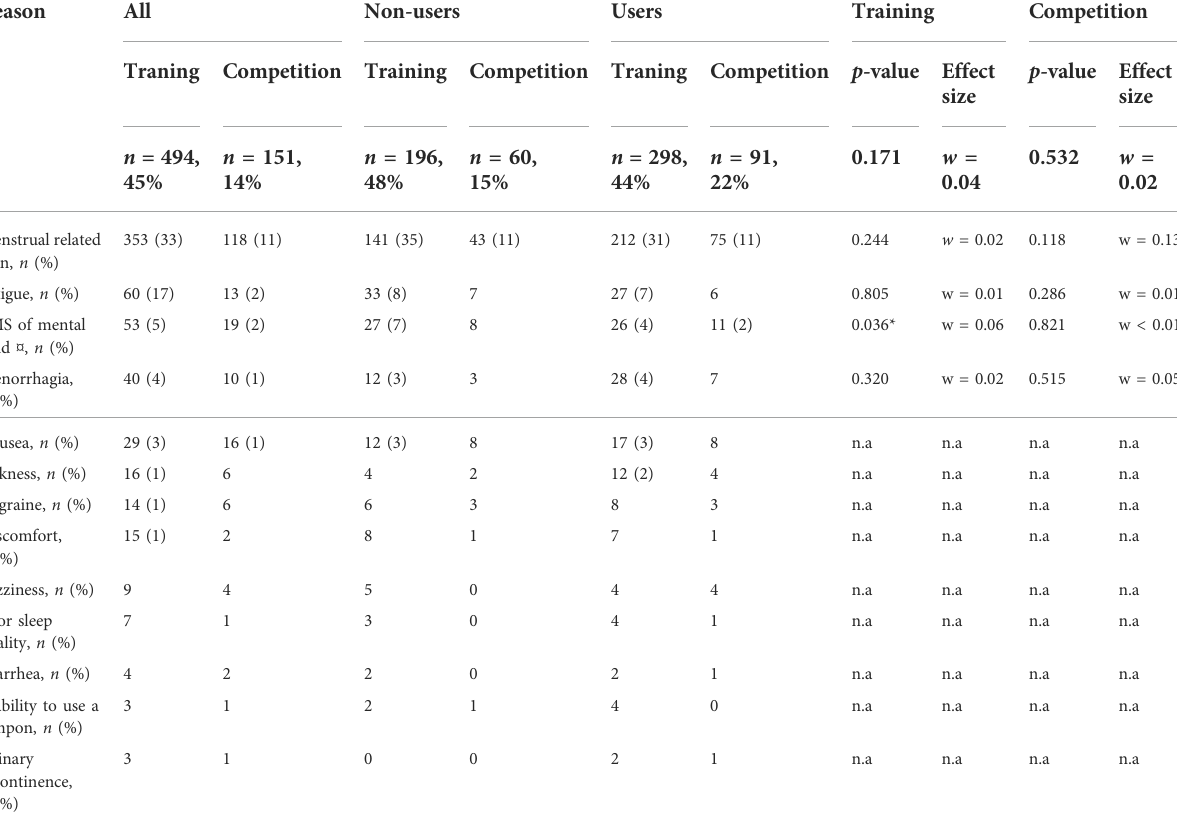
TABLE3 Thenumbers(percentage)ofrespondentswhoreportedrefraining fromtraining ( n =494) and/orcompetition( n =151)for different reasons related to their menstrual cycle or usage of hormonal contraceptives. Premenstrual symptoms of mental kind were signi fi cantly more frequent reported in the non-users ( p = 0.036) of HCs. Every athlete report one or two reasons to refrain from training or competition. Reason All